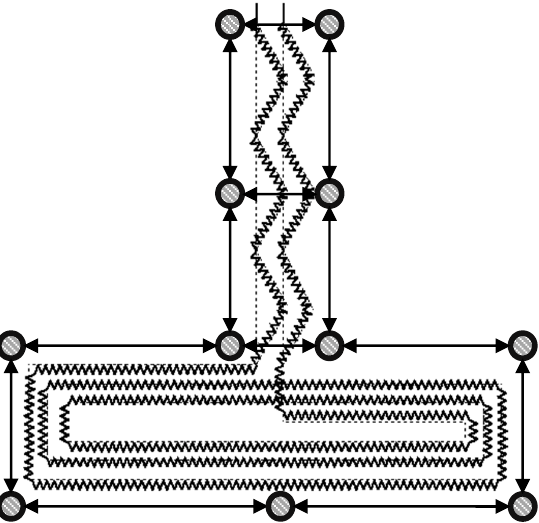
Figure 3. Placement of optical markers around the proposed shape for the inductive sensor. Markers are shown as grey circles.